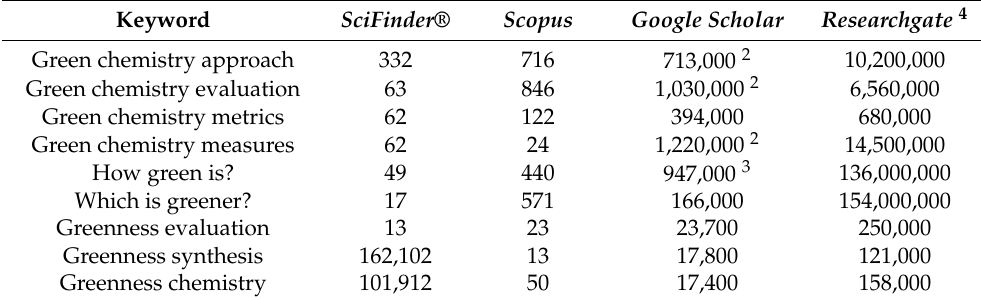
Table 2. References in the main search databases 1